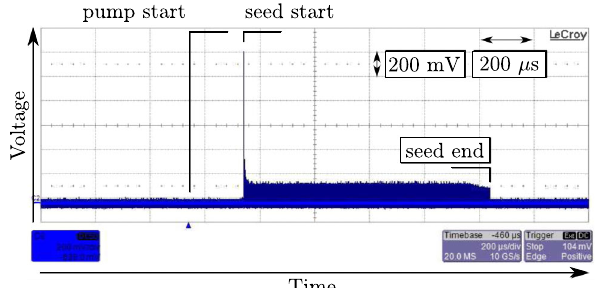
FIG. 4. Oscilloscope screenshot showing a 20